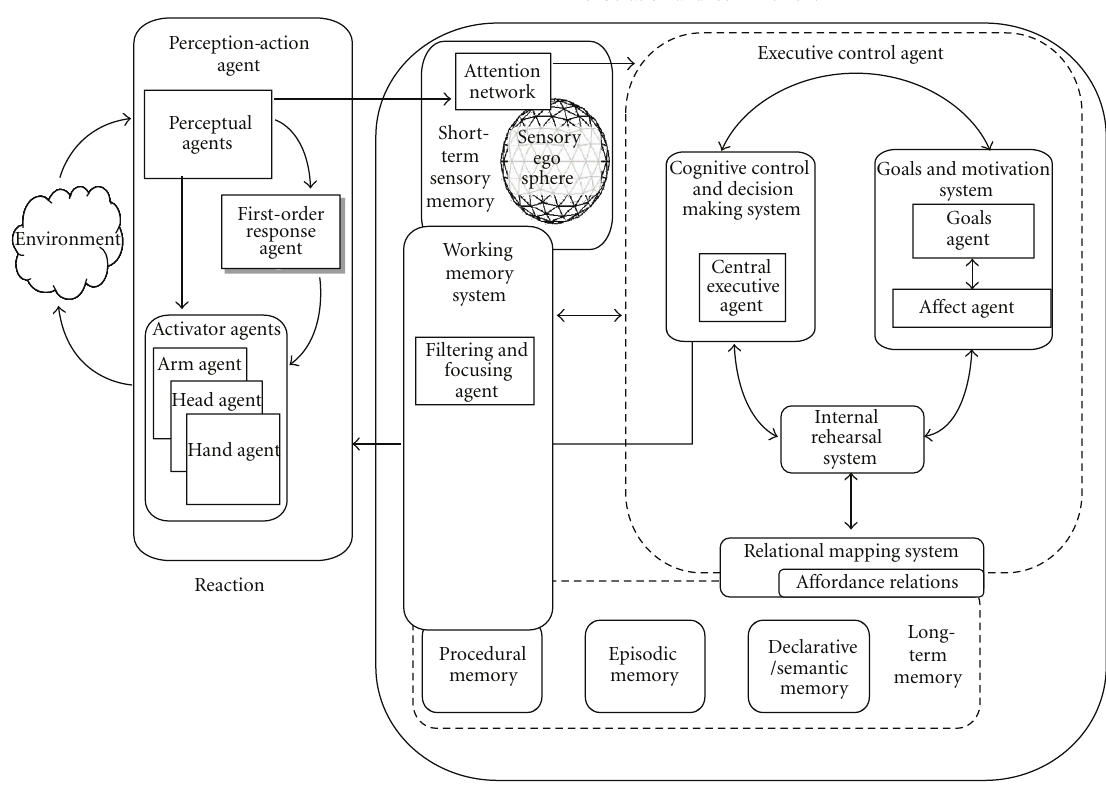
Figure 4: ISAC cognitive architecture.